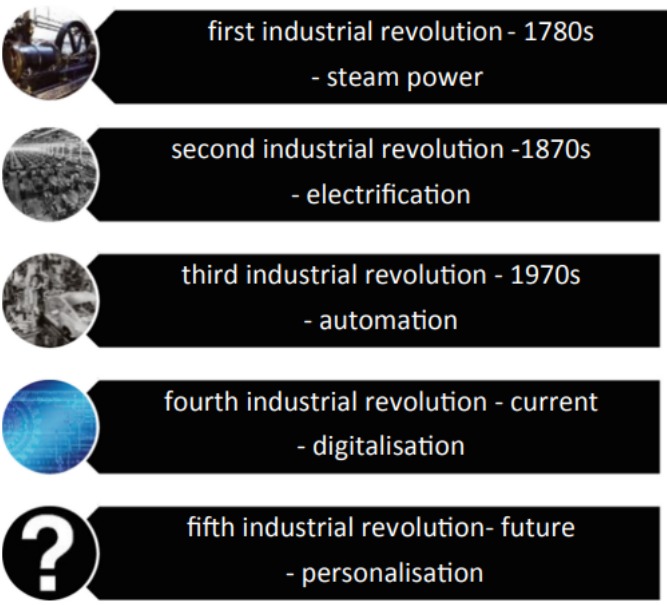
Figure 1. Industrial revolutions and their core technologies